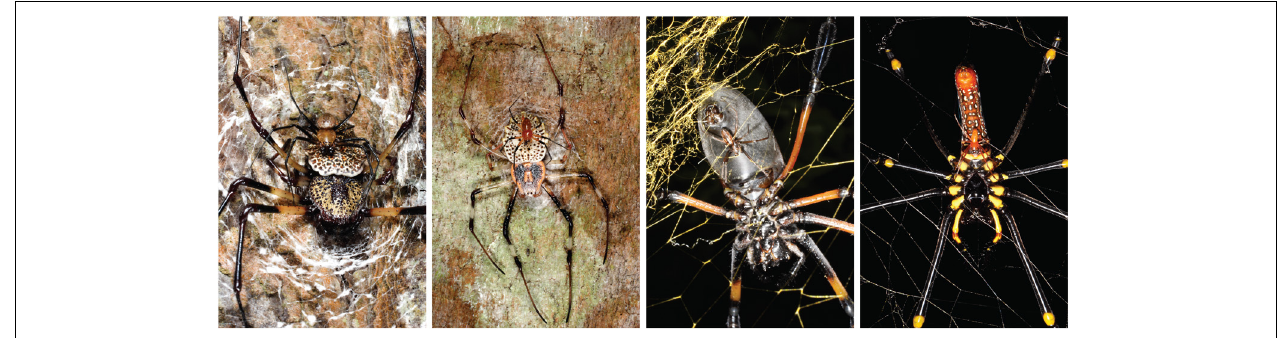
FIGURE 1 | Female biased sexual size dimorphism in nephilid spiders: From left to right, small males on females in Herennia etruscilla, H. multipuncta, Nephila inaurata , and N. pilipes